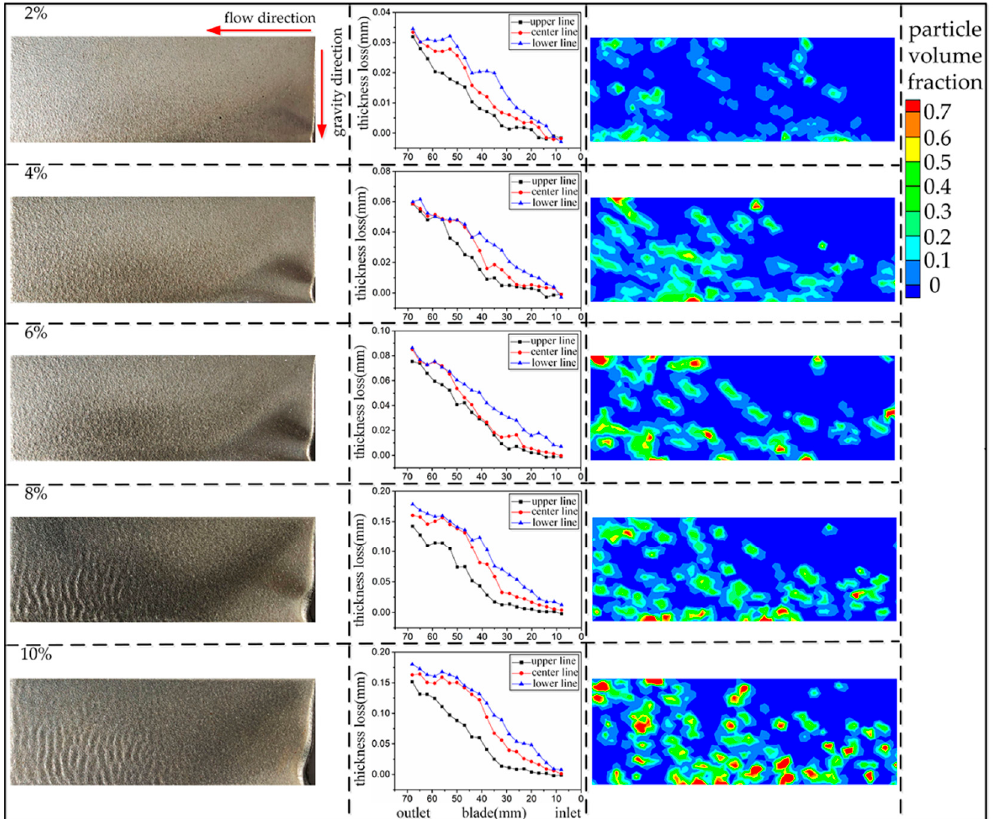
Figure 14. Wear for different particle concentrations at 600 rpm.